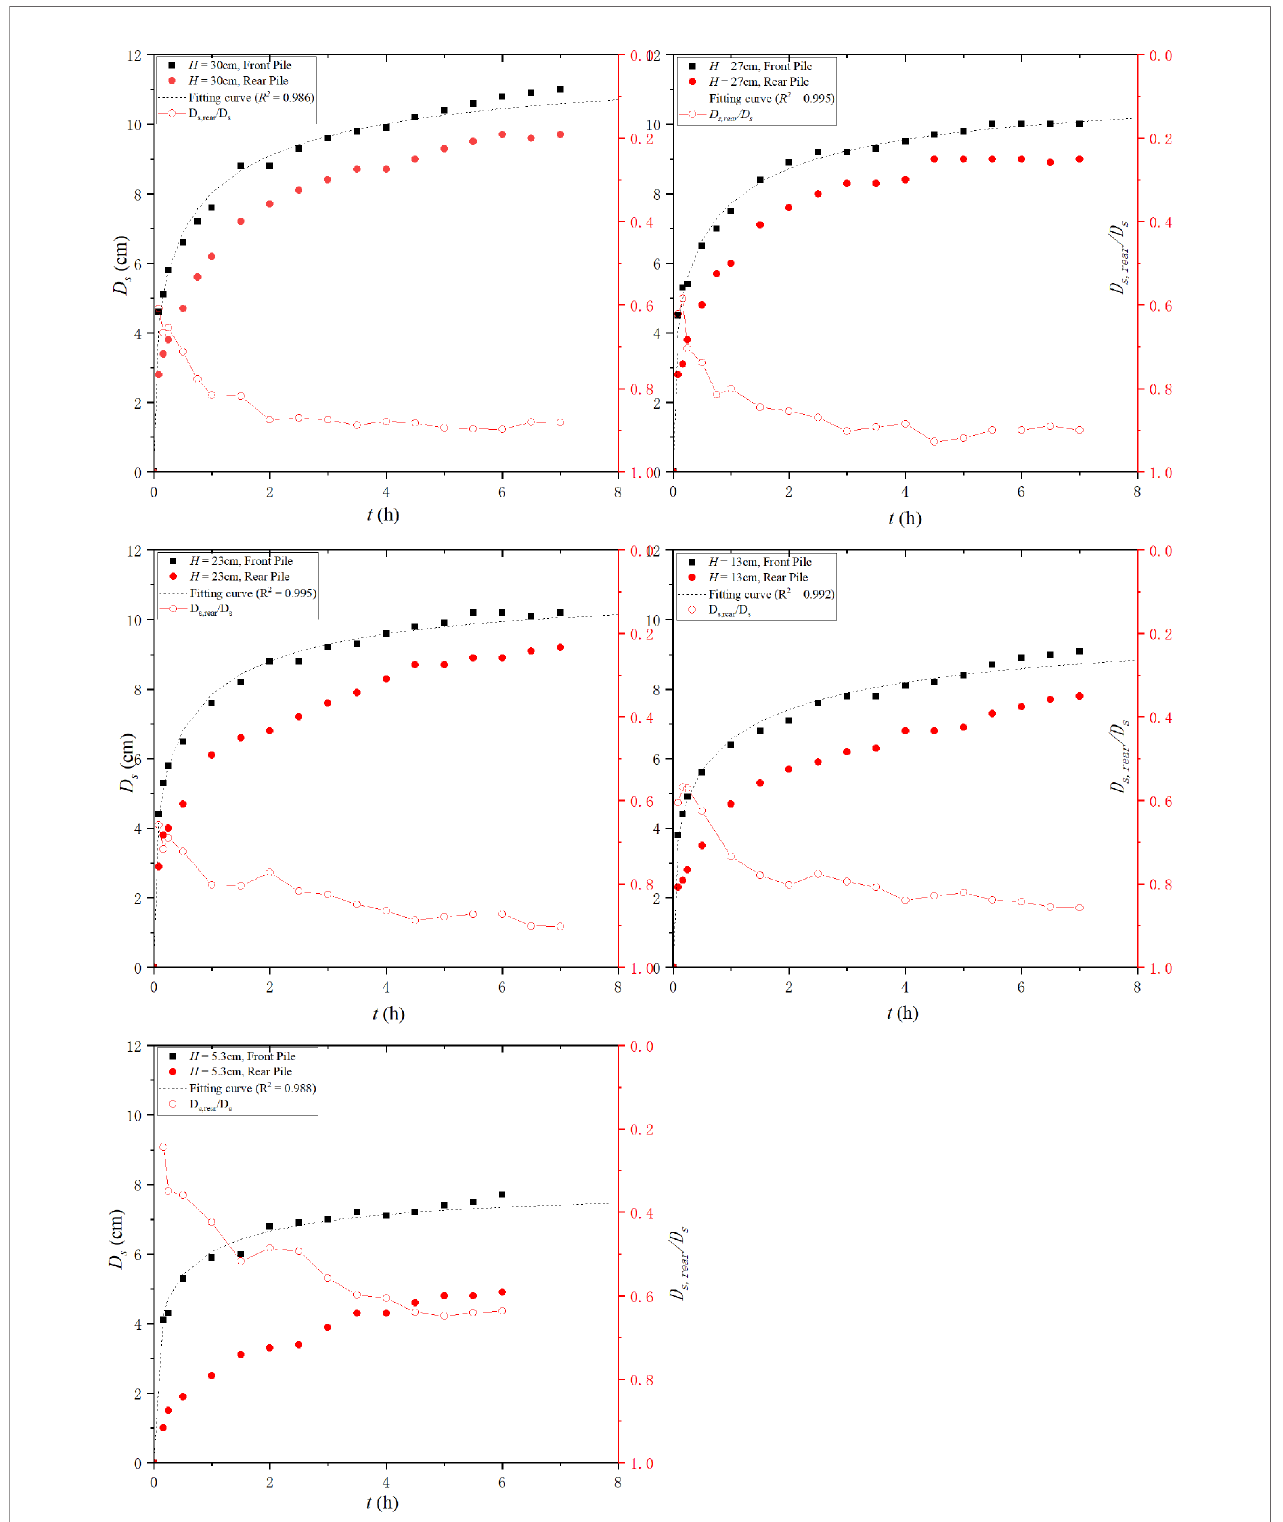
FIGURE 6 | Temporal development of scour depth around front pile and rear pile ( U / U c =